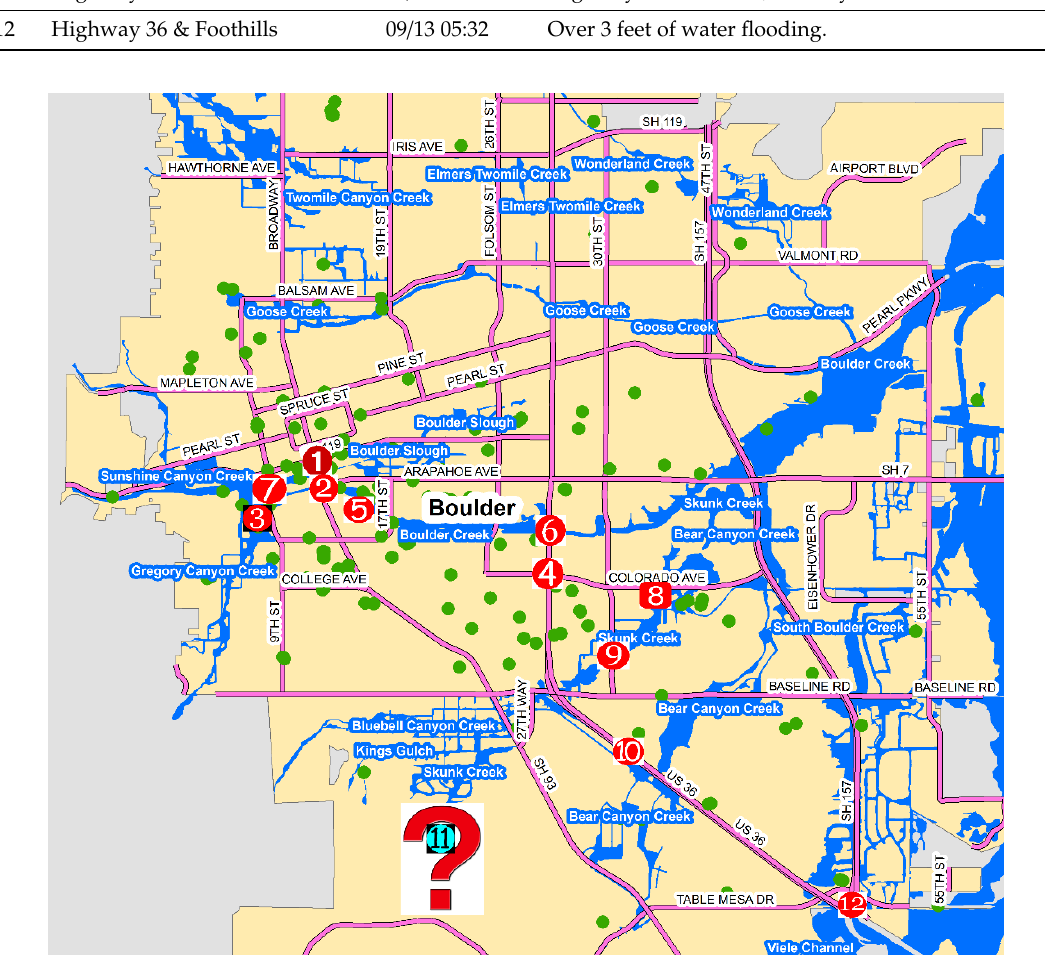
Figure 2. Example of identified roads/streets.